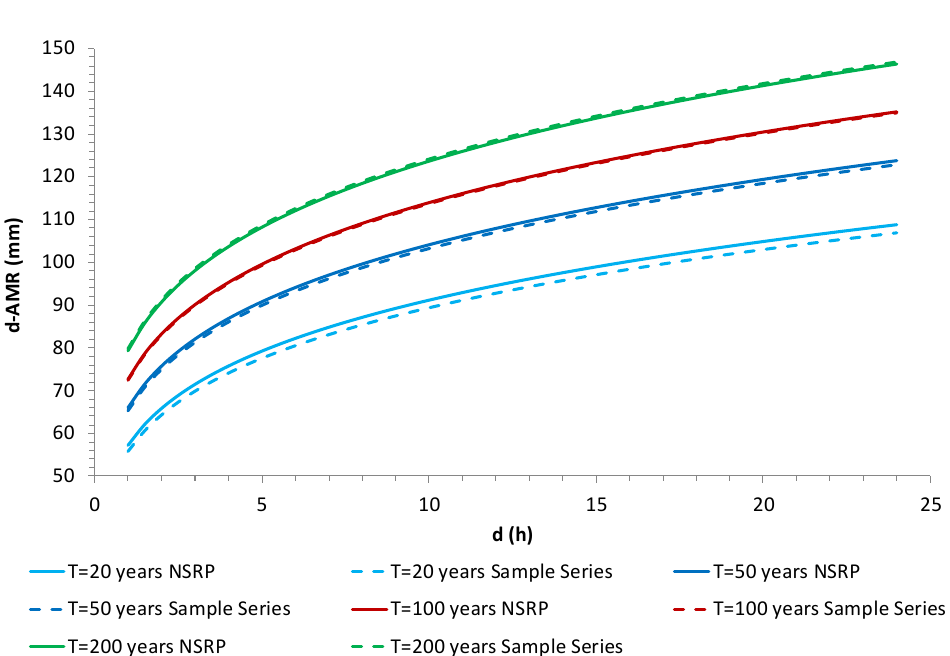
Figure 5. Viterbo rain gauge: sample and NSRP ADF curves.